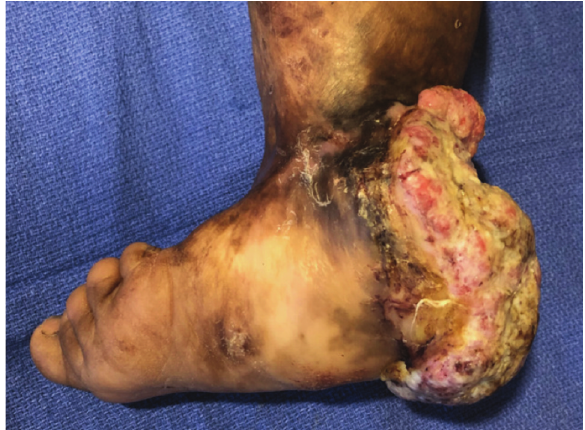
Medial view of the foot. Measuring 6x10x12cm at its Fig. 1: widest dimensions, the fungating mass extends from 6cm cephalad to the malleoli to the plantar aspect of the heel. It started as a recurrent blister at the heel similar to the lesion indicated by the arrow. Burn scars involve the entire foot and distal leg.